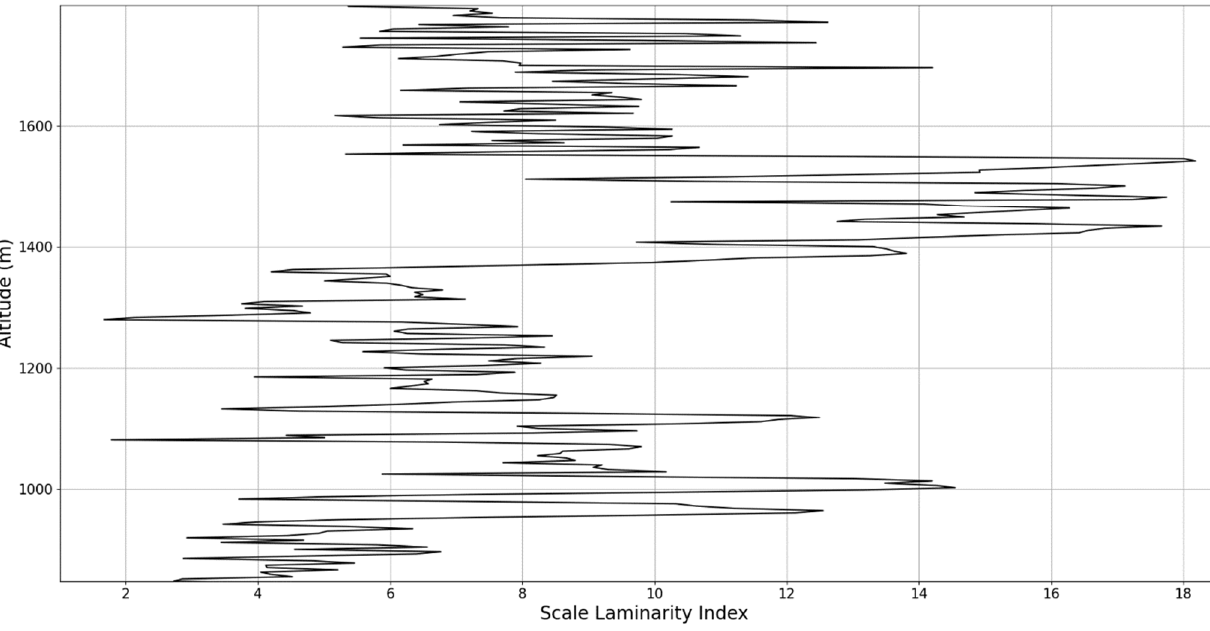
Figure 34. Scale laminarity index profile plot corresponding to point C in the vicinity of the PBLH.